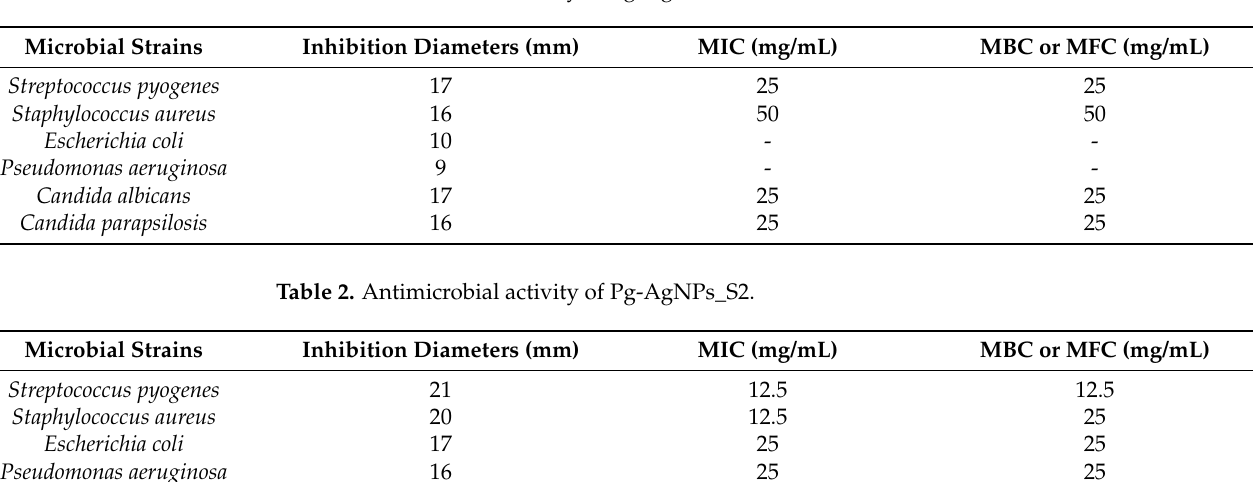
Table 1. Antimicrobial activity of Pg-AgNPs_S1.